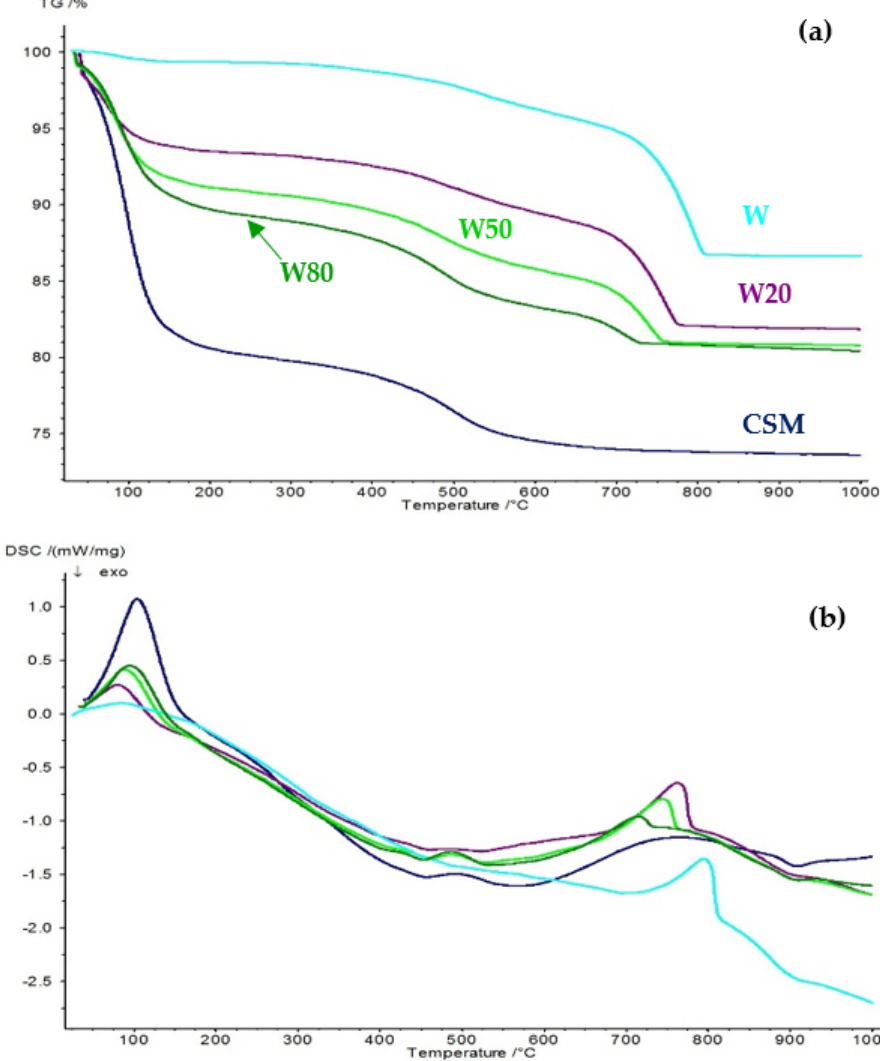
Figure 3. ( a ) TG and ( b ) DSC curves of the raw materials (W and CSM) and their blends (W20, W50, W80). Heating rate 10 K/min under nitrogen atmosphere.